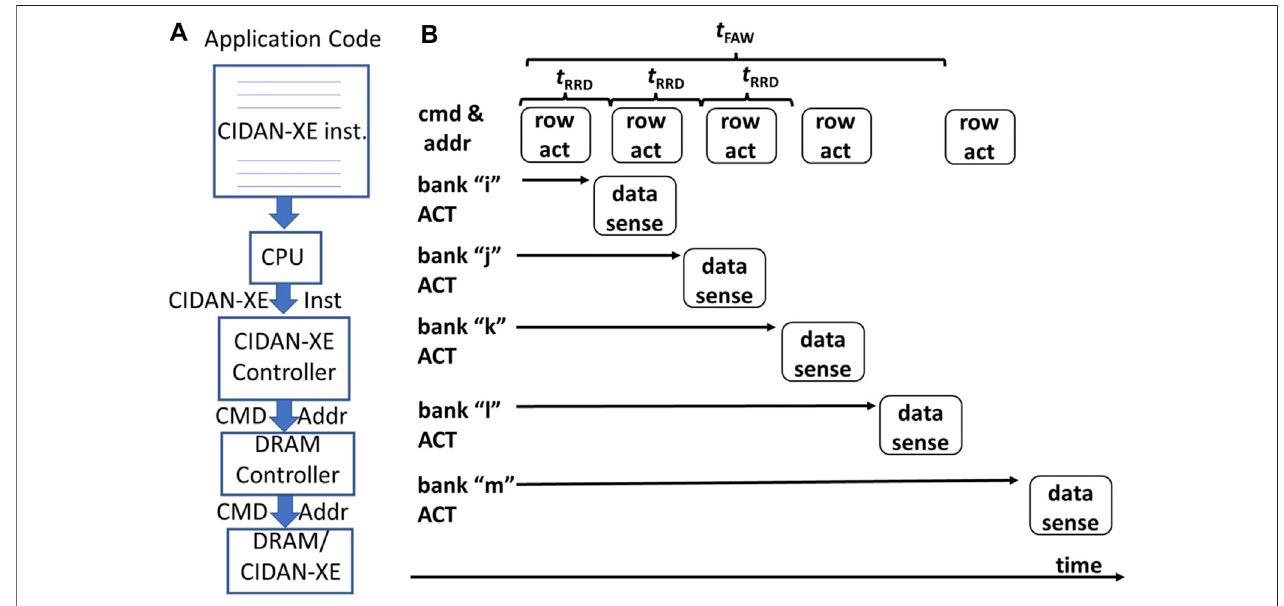
FIGURE 9 | (A) System-level Integration of DRAM and (B) Activation commands to different banks within four bank activation window.